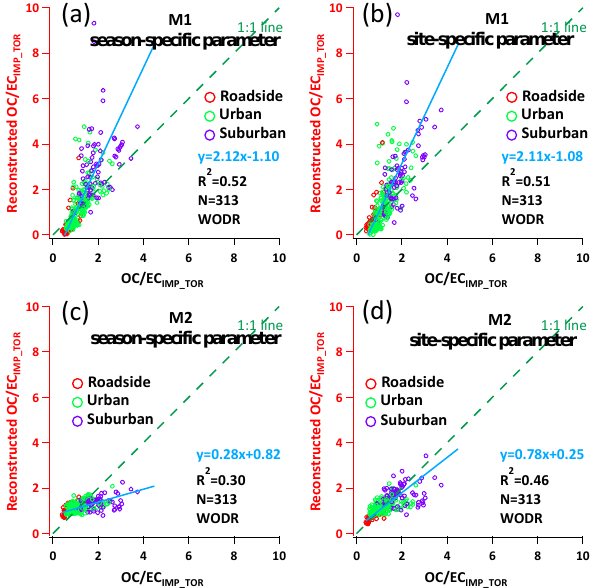
Figure 9. Reconstruction results of OC / EC IMP_TOR . (a) Recon- struction by season-specific parameters using M1. (b) Reconstruc- tion by site-specific parameters using M1. (c) Reconstruction by season-specific parameters using M2. (d) Reconstruction by site- specific parameters using